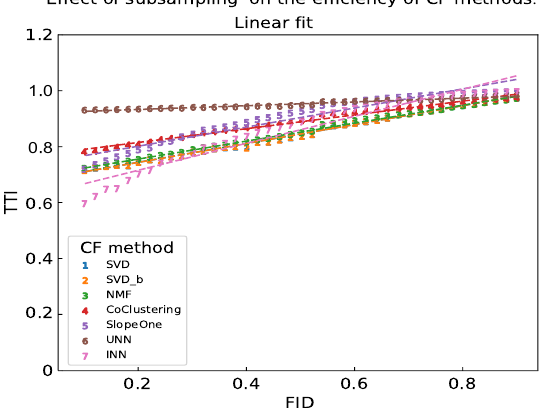
Fig. 2 TTI versus FID using P 1 at constant FUD =0.7.